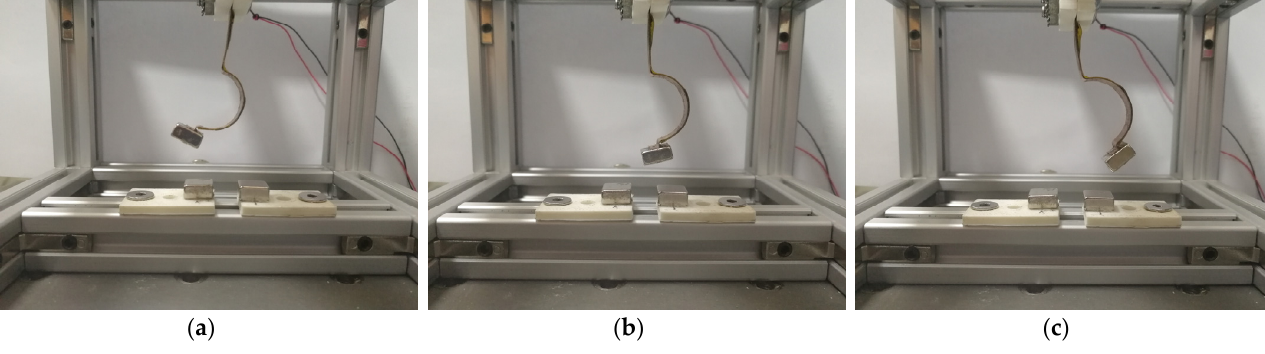
Figure 10. Experimental phase portrait of different excitation accelerations: ( a ) a = 5 m/s 2 ; ( b ) a = 7 m/s 2 ; ( c ) a = 12 m/s 2 .